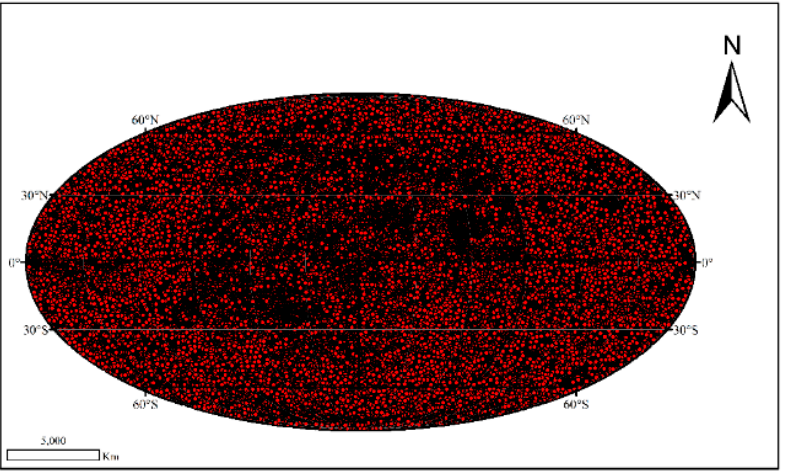
Figure 12. The impact crater distribution map of the Moon. (The bottom image is the DOM image of Chang ‘E-2 with a resolution of 7 m, Mollweide projection, and the impact crater is the detection result of the GL-HRNet model.)